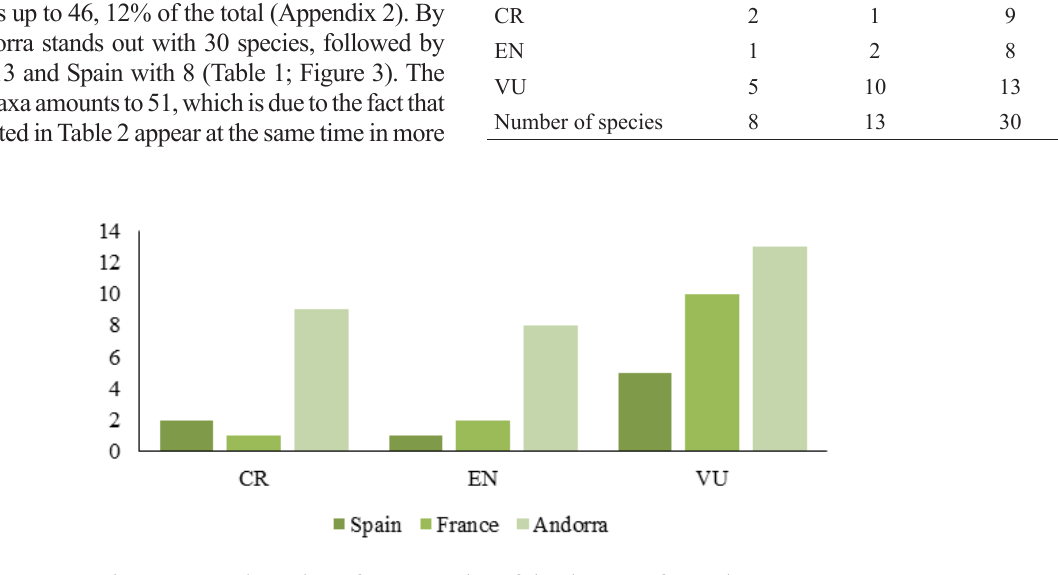
Figure 3. Total number of AFC species of the three RL for each category.